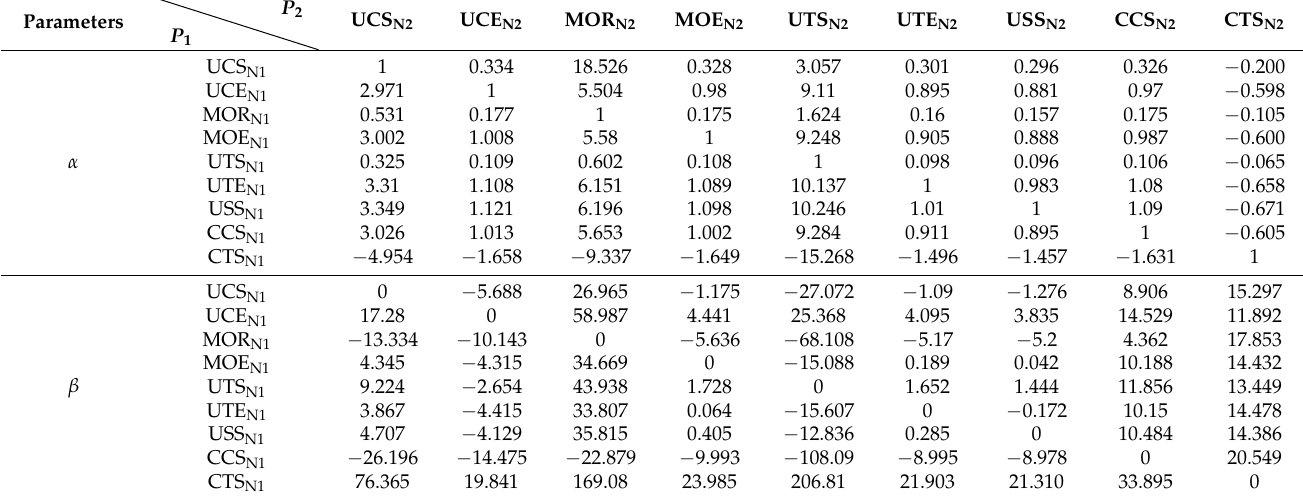
Table 6. Mechanical property conversion parameters of internode